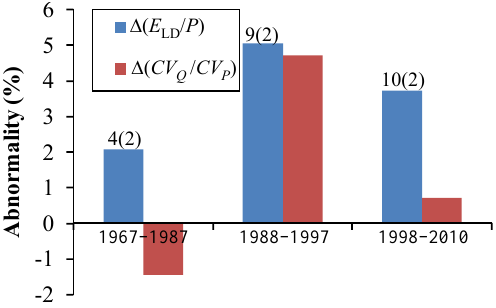
Figure 11. Histogram of the (cid:49) ( E LD /P ) data determined with Eq. (24) and the (cid:49) ( CV Q / CV P ) data determined with the coeffi- cients of intra-annual variation of the monthly runoff ( CV Q ) and rainfall ( CV P ) for the different periods in catchment C1. The num- bers of diversions (reservoirs) are shown on the top of the blocks according to Table